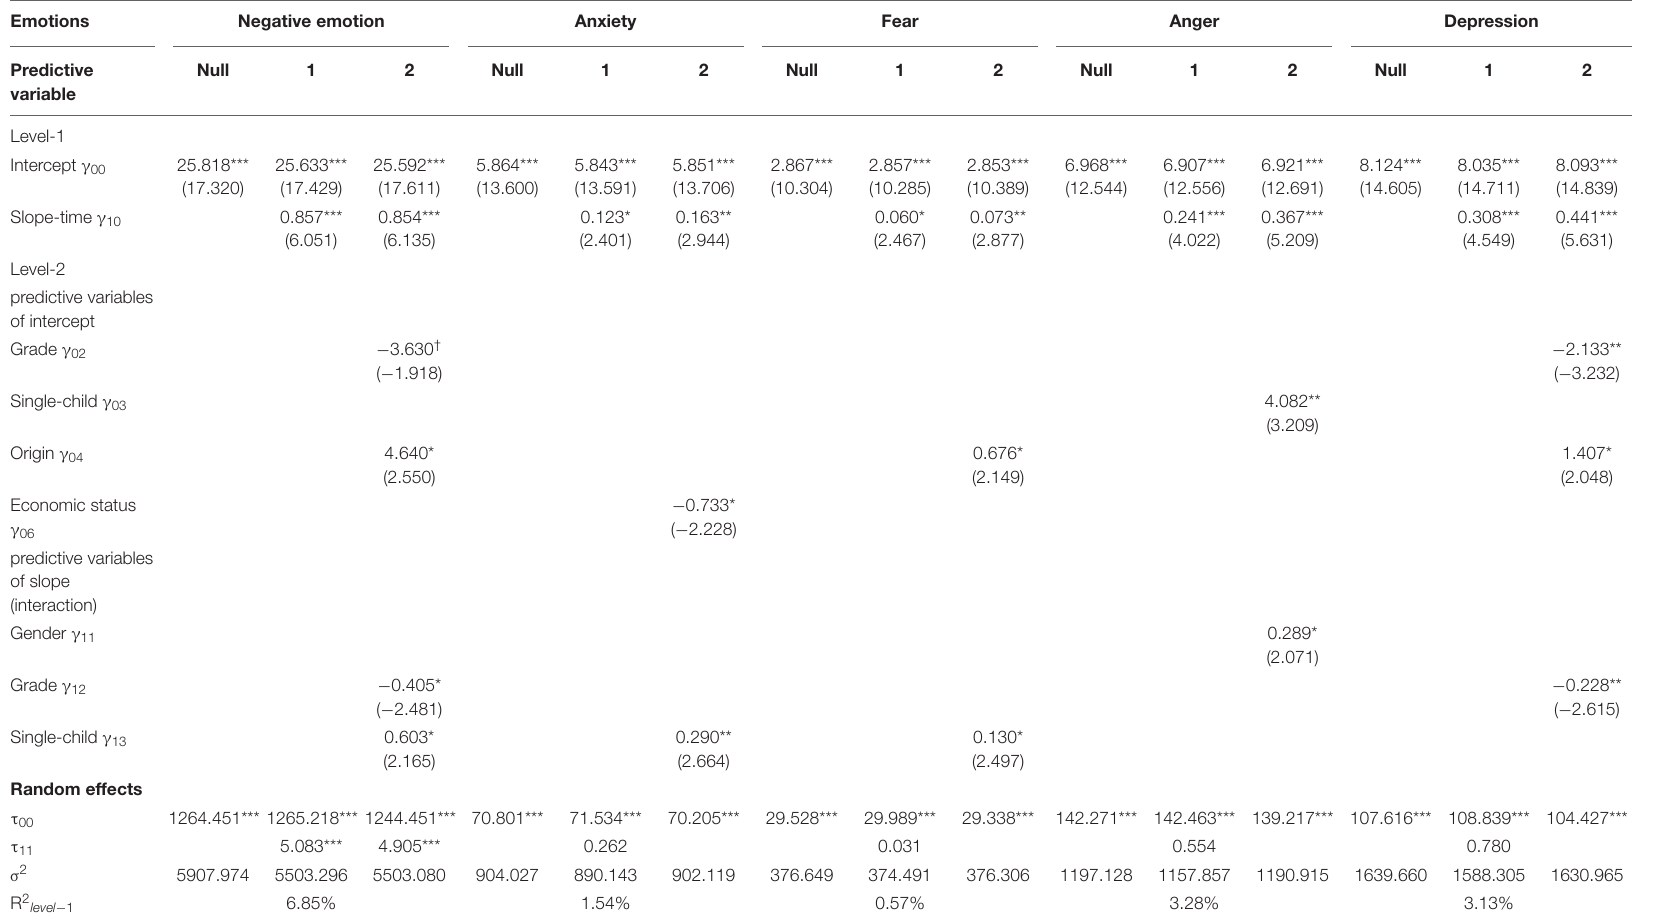
TABLE 4 | Multilevel linear model of negative emotion and its subcategories. Emotions Negative emotion Anxiety Fear Anger